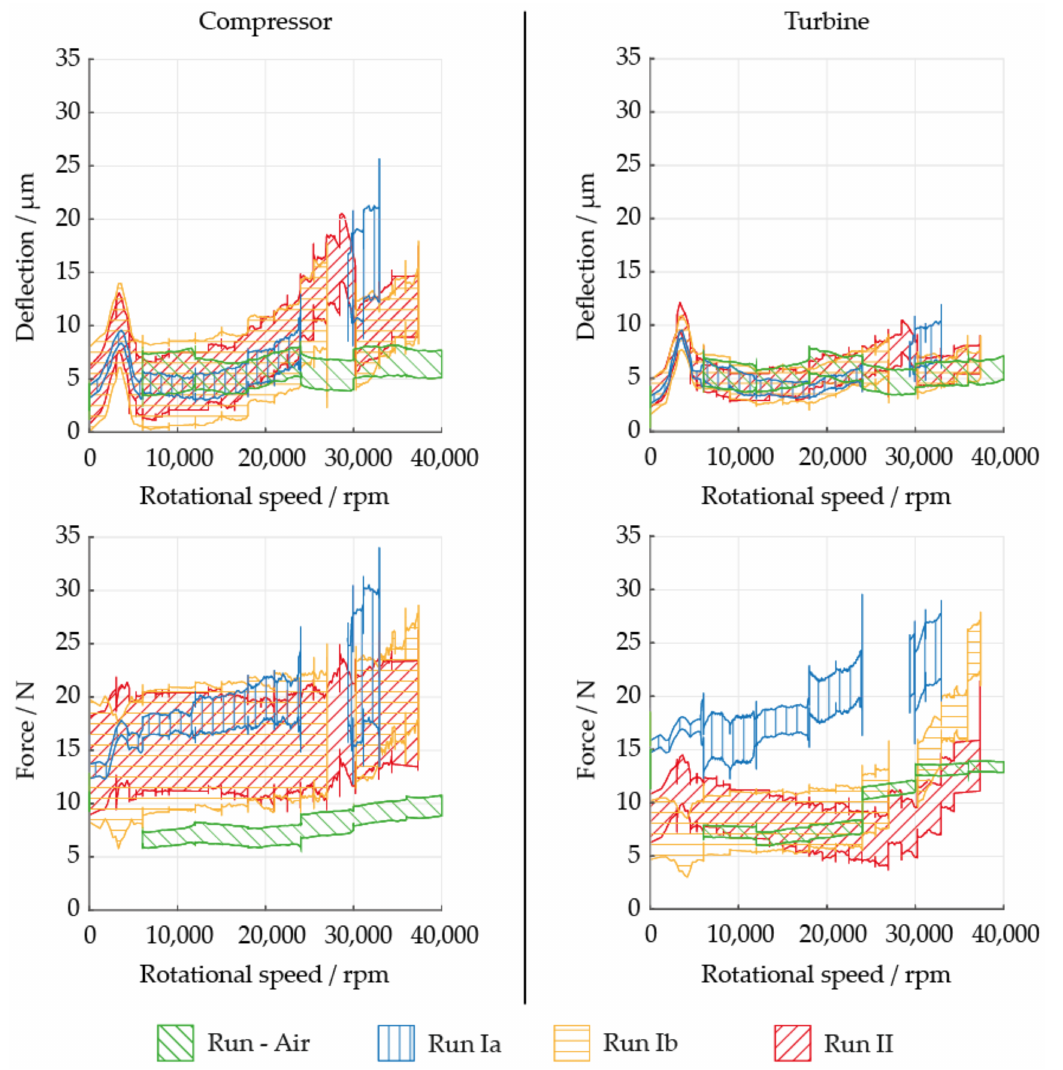
Figure 8. Deflections and forces depicted as function of speed for region I and II in Figure 6 for three test runs compared to the air test: ( top ) deflections; ( bottom ) forces; ( left ) at compressor bearing; ( right ) at turbine